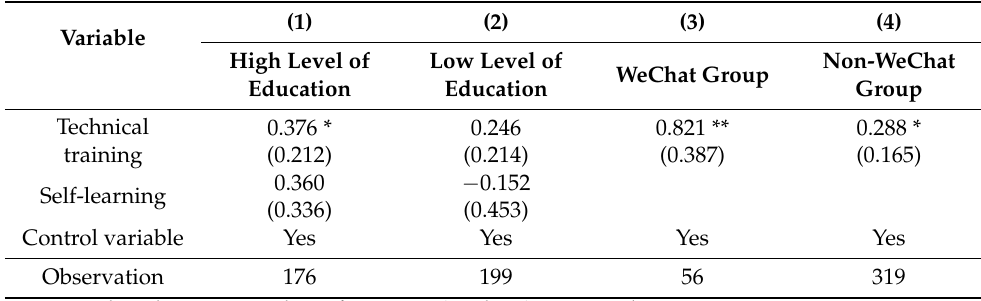
Table 8. Heterogeneous effects of technology training and self-learning on the willingness of different types of farmers to adopt